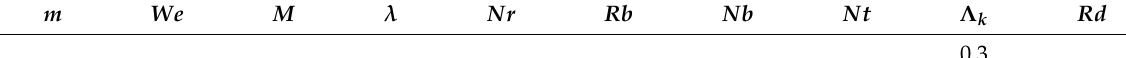
Table 5. Numerical outcomes for Re